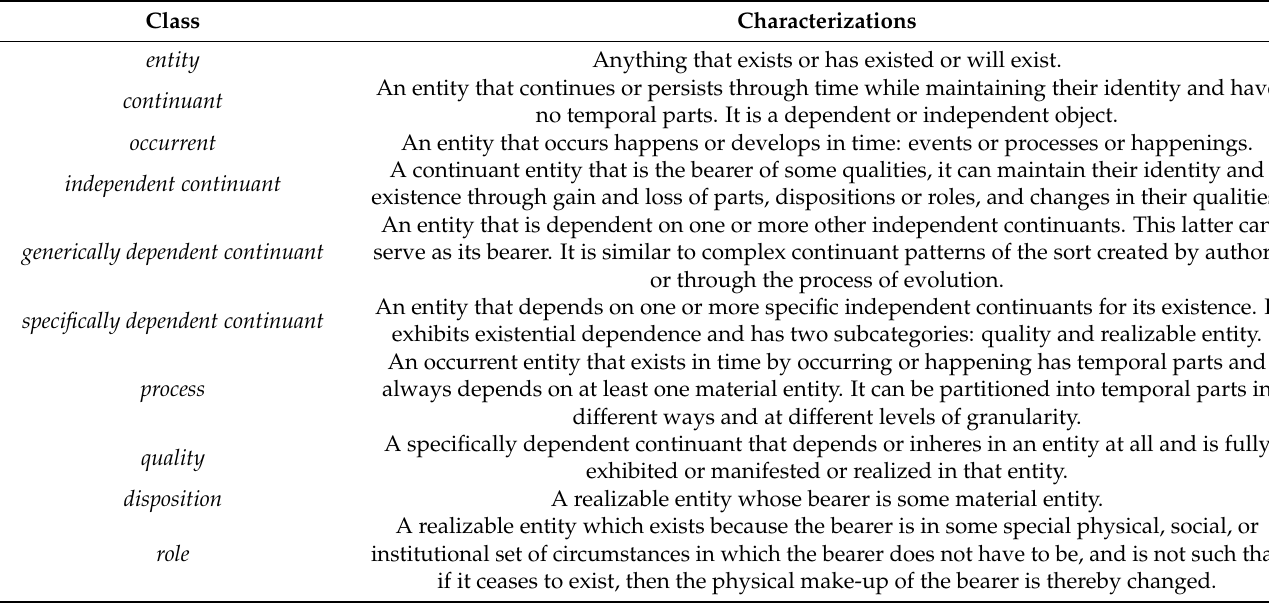
Figure 4. A fragment of the BFO’s classes hierarchy. Table 2. BFO classes and their